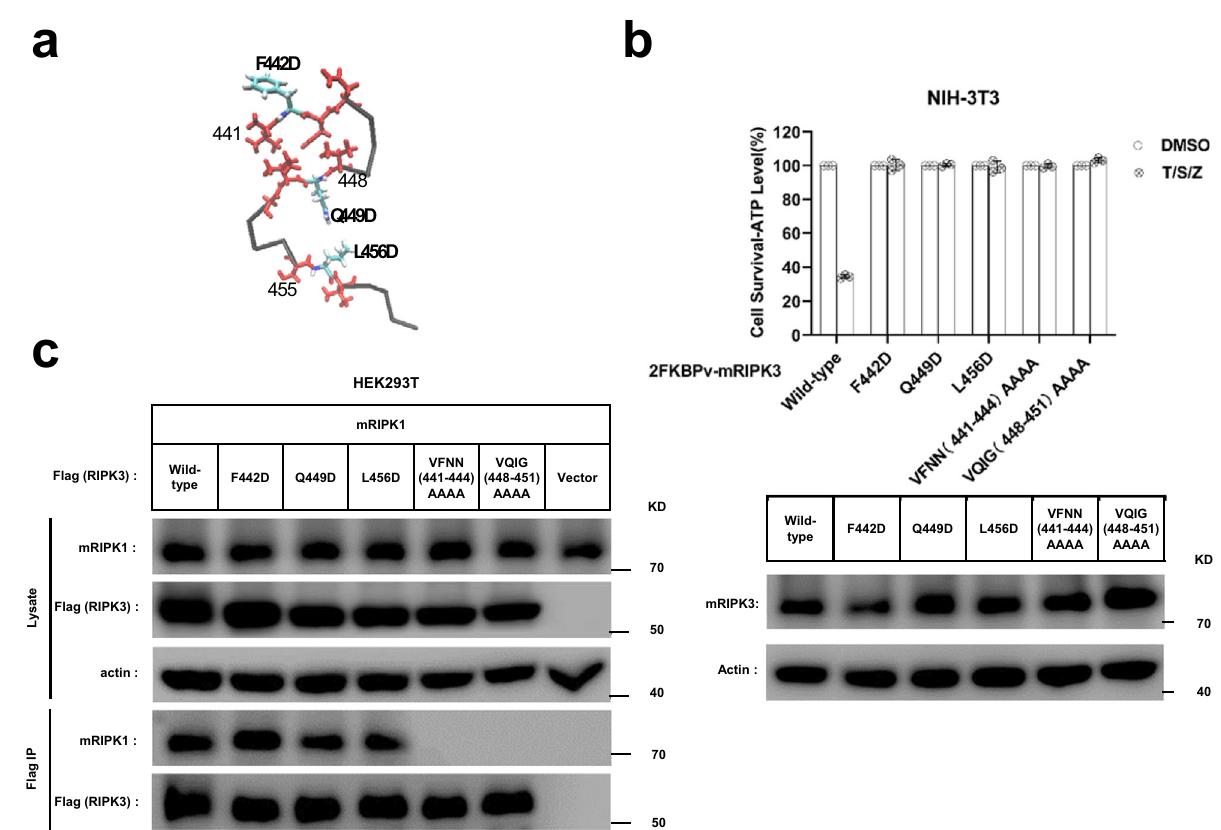
Fig. 7 Cell-based functional assay. a The monomer structure of mouse RIPK3, showing the three β -strand segments in red and three single mutation sites. b Mutation of F442, Q449, or L456 to D, or quadruple alanine mutations of 441 VFNN 444 or 448 VQIG 451 in RIPK3 led to the complete disruption of the TNF- induced cell necroptosis. The NIH-3T3 cells infected with lentivirus containing FKBPv fused wild-type or mutant RIPK3 were treated with TNF- α /Smac/z- VAD (T/S/Z) 10 h. The number of surviving cells were determined by measuring ATP levels using Cell Titer-Glo kit (upper). Data are presented as mean ± SD of n = 3 biologically independent replicates. Source data are provided as a Source Data fi le. Aliquots of 20 μ g whole-cell lysates were subjected to SDS- PAGE followed by western-blot analysis of mouse RIPK3 and β -Actin which was shown as a loading control (lower). c The RIPK3 mutant F442D, Q449D, L456D did not affect the interaction between mouse RIPK1 and mouse RIPK3. The HEK293T cells were co-transfected with DNA plasmids containing mouse RIPK1 and Flag-tagged mouse RIPK3 (or its mutants). Cell lysates were collected 36 h post transfection, and immunoprecipitated with anti-Flag magnetic beads (Bimake) at 4 °C. The total cell lysates and immunoprecipitates were analyzed by western-blot analysis with the indicated antibodies. All experiments were repeated three times. The following antibodies were used in this study: anti-mRIPK3 (Sigma-Aldrich, PRS2283, 1:3000); anti-RIPK1 (Cell Signaling Technology, D94C12, 1:1000); Anti-actin (MBL, PM053-7, 1:10,000). Uncropped blots in the Source Data fi